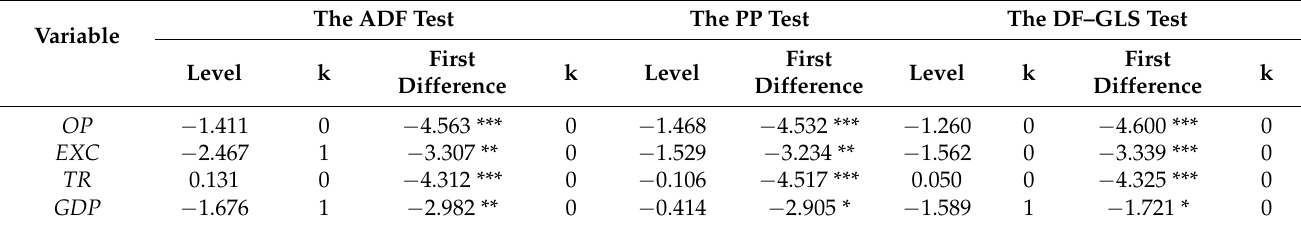
Table 1. Outcomes of unit root